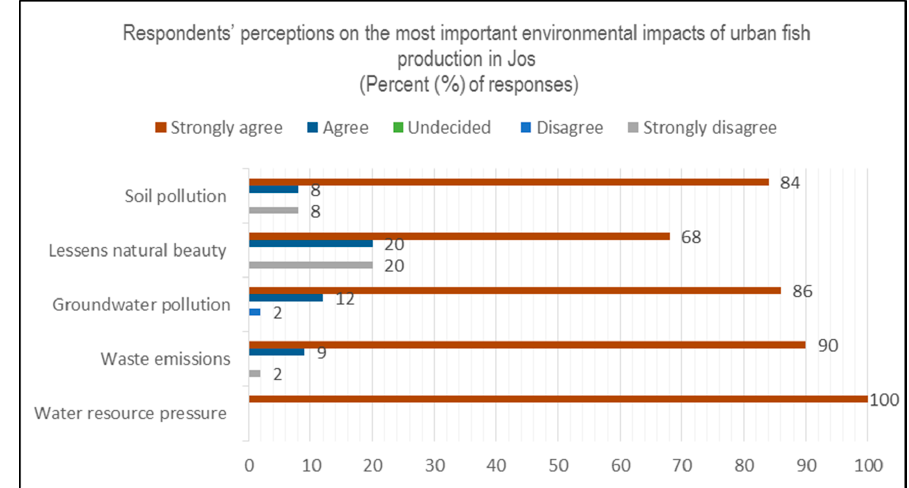
Figure 7. Respondents’ perceptions on the most important environmental impacts of urban fish production in Jos.